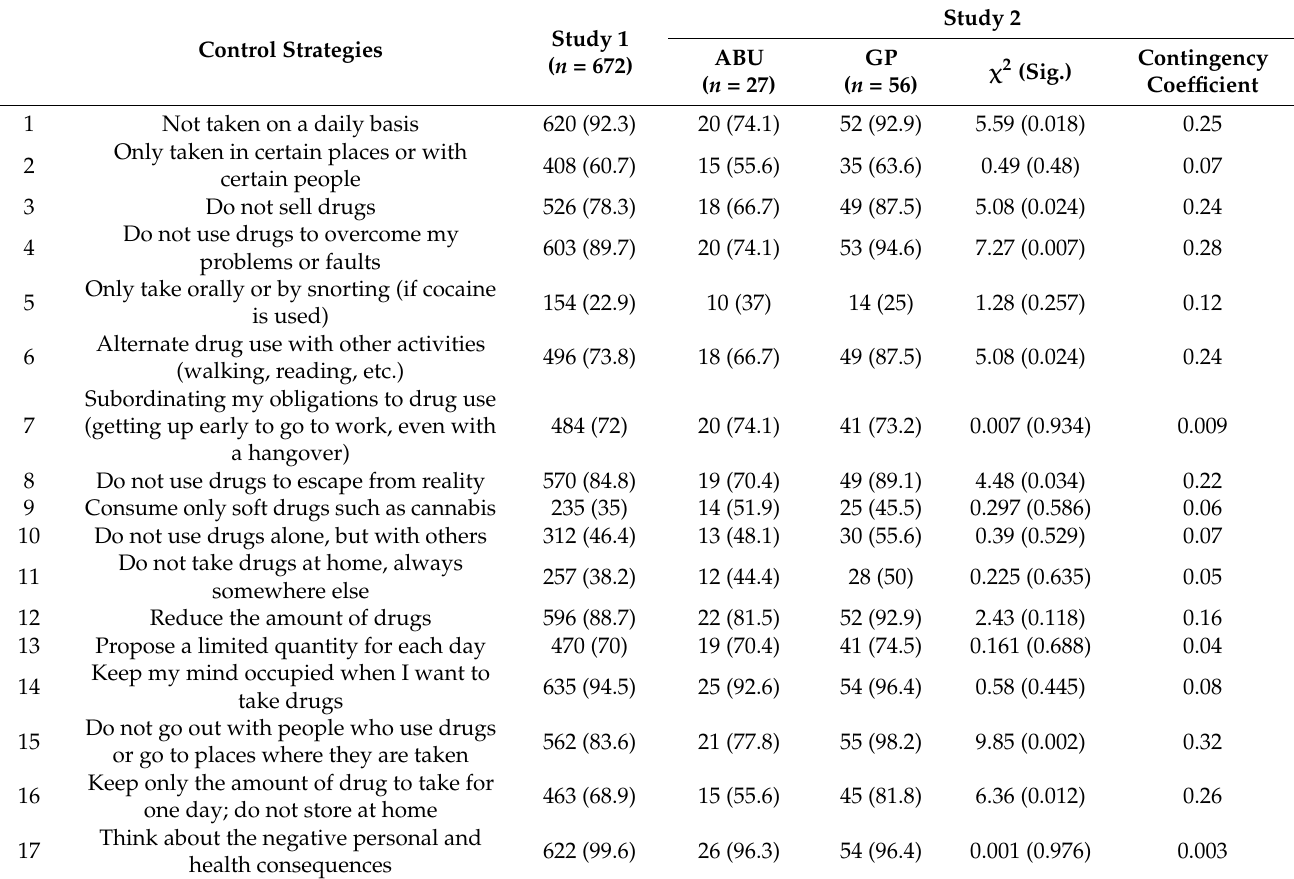
Table 6. Favourable views (in percentages) of using some of 17 drug use control strategies for all groups. Study Control Strategies